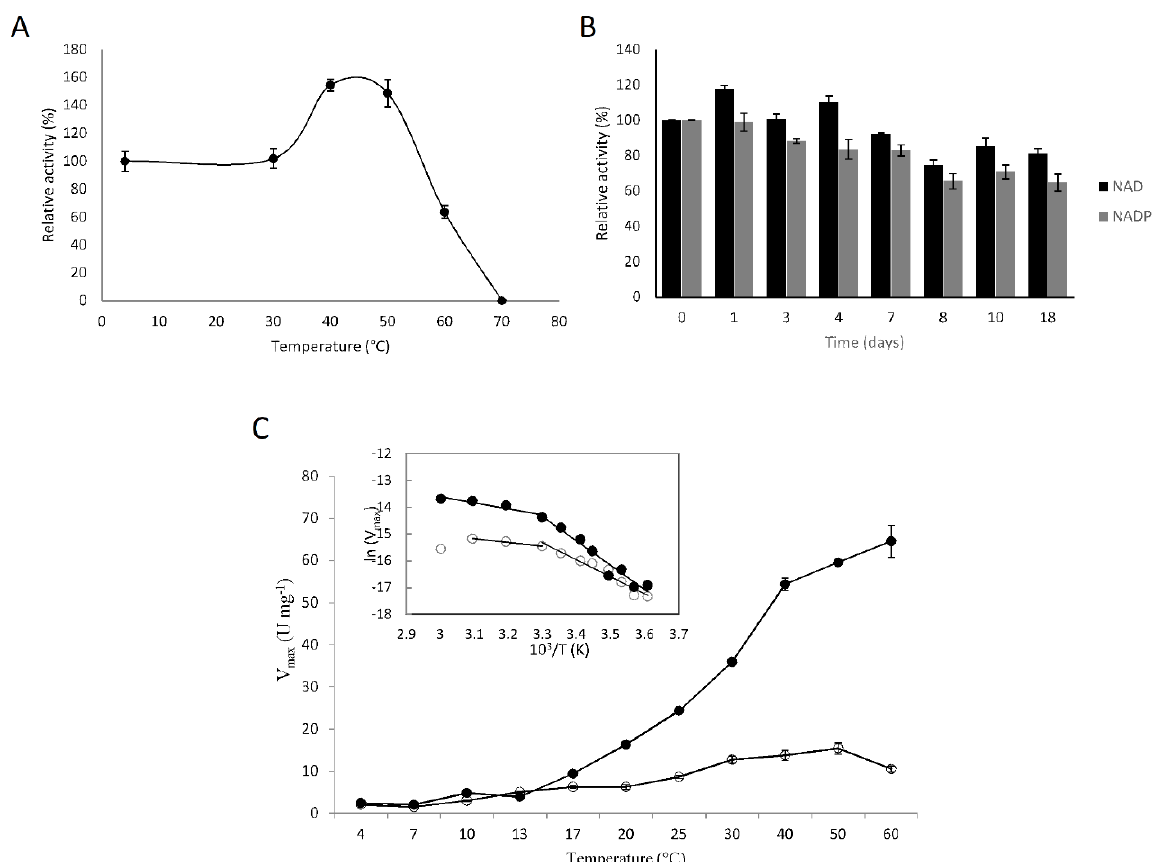
Figure 6. Temperature effect on the stability and activity of F-ALDH. ( A ) Thermal stability of the enzyme was determined after incubating the enzyme (200 ng) for 10 min at various temperatures in the 4–70 °C interval, and further measuring the activity at 25 °C, in the presence of benzaldehyde and NAD +. ( B ) Long term stability of F-ALDH was evaluated after storing the purified enzyme at 4 °C for up to 18 days, and the activity when using NAD + (black) and NADP + (grey) as cofactors was measured at 25 °C. ( C ) The effect of temperature on the F-ALDH activity was determined by measuring the reaction at different temperatures. Isovaleraldehyde saturation curves were performed at various temperatures in the 4–60 °C interval in the presence of NAD + (●) and NADP + ( ○ ), and the maximum velocity (V max ) was calculated as described in Methods. The inset shows the corresponding Arrhenius plots.